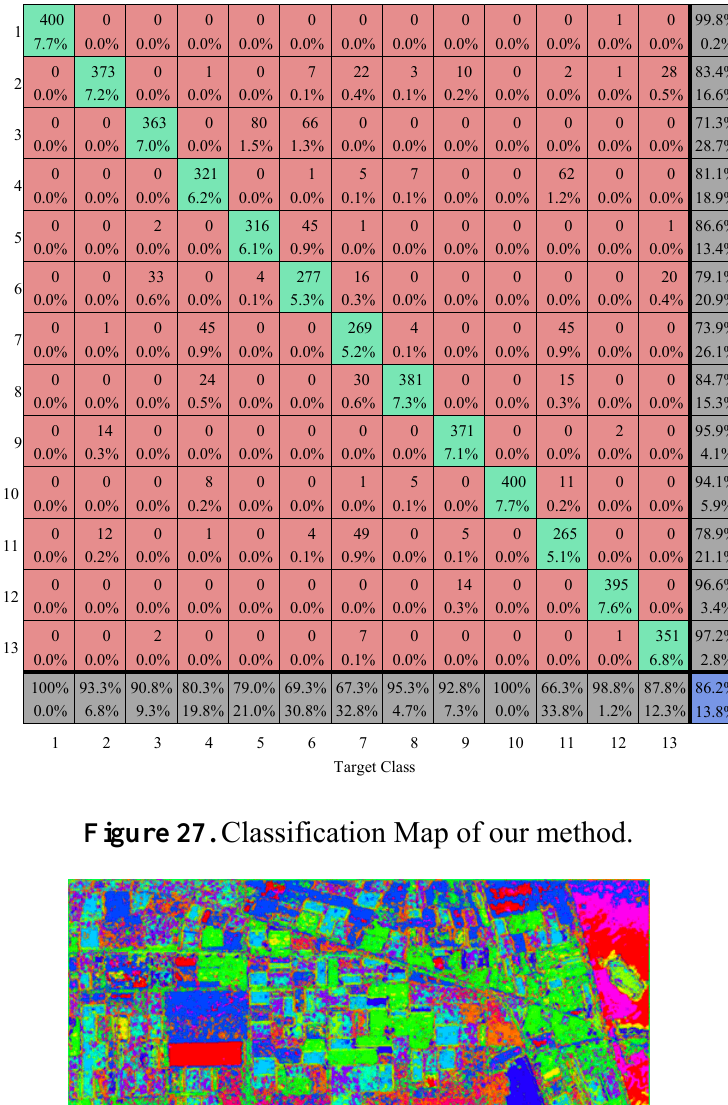
Figure 26. Confusion matrix comparison on test area (values are given in percent) The overall vccuracy is 86.2%.